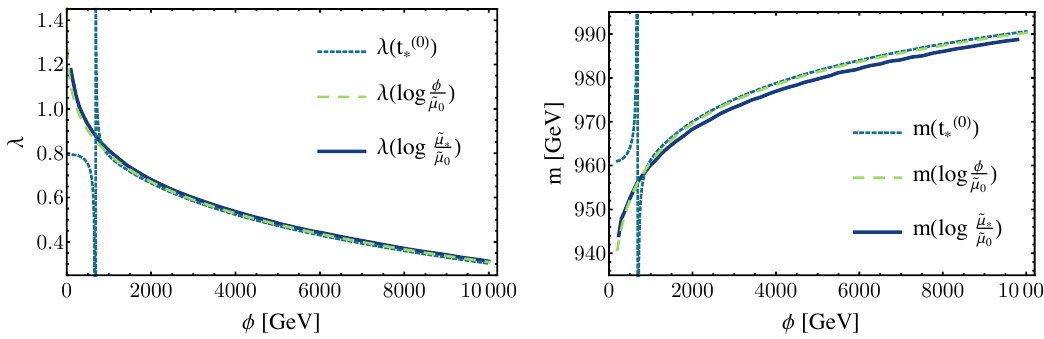
Figure 5 . The running coupling constant (cid:21) (left panel) and the running mass term m (right panel) evaluated at di(cid:11)erent (cid:12)eld-dependent scales: t (0) (cid:3) , log (cid:30) The curves for log ~ (cid:22) (cid:3) are reproduced from ref. ~ (cid:22) 0